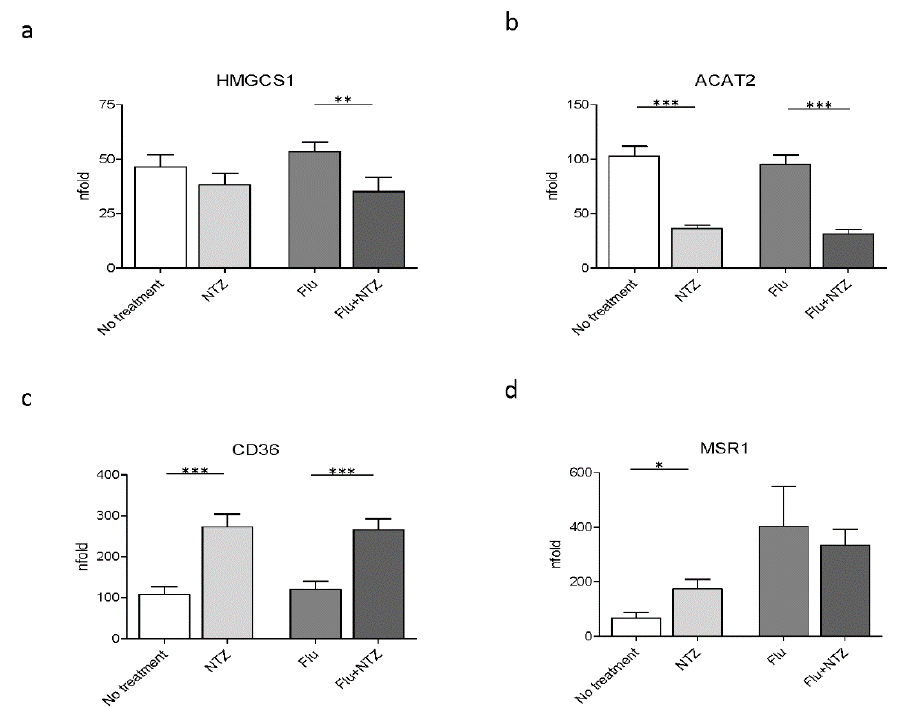
Figure 2. FLU and NTZ downregulate cholesterol biosynthesis, but induce scavenger receptors. PBMCs from healthy donors ( n = 12) were stimulated for 4 h with FLU antigens, NTZ or both in combination. mRNA levels of the biosynthetic genes HMGCS1 ( panel a ) and ACAT1 ( panel b ), together with the scavenger receptors CD36 ( panel c ) and MSR1 ( panel d ), were analyzed by Real Time PCR. Mean values ± standard error are reported. The statistically significant differences are marked with one, two or three asterisks, which indicate a p -value equal or less than 0.05, 0.001 or 0.0001, respectively. Statistic was determined by t-test analyses.